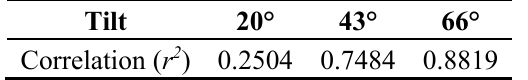
Figure 11. Comparison of modeled angular reflectance Soil-Canopy-Observation of Photosynthesis and the Energy balance (SCOPE) with the unmanned aerial vehicle (UAV) measured values for MERZ1. Shown are two exemplary wavelengths, which are scaled to the present range of values. Table 5. Correlation of modeled data with measured data for different tilt angles.